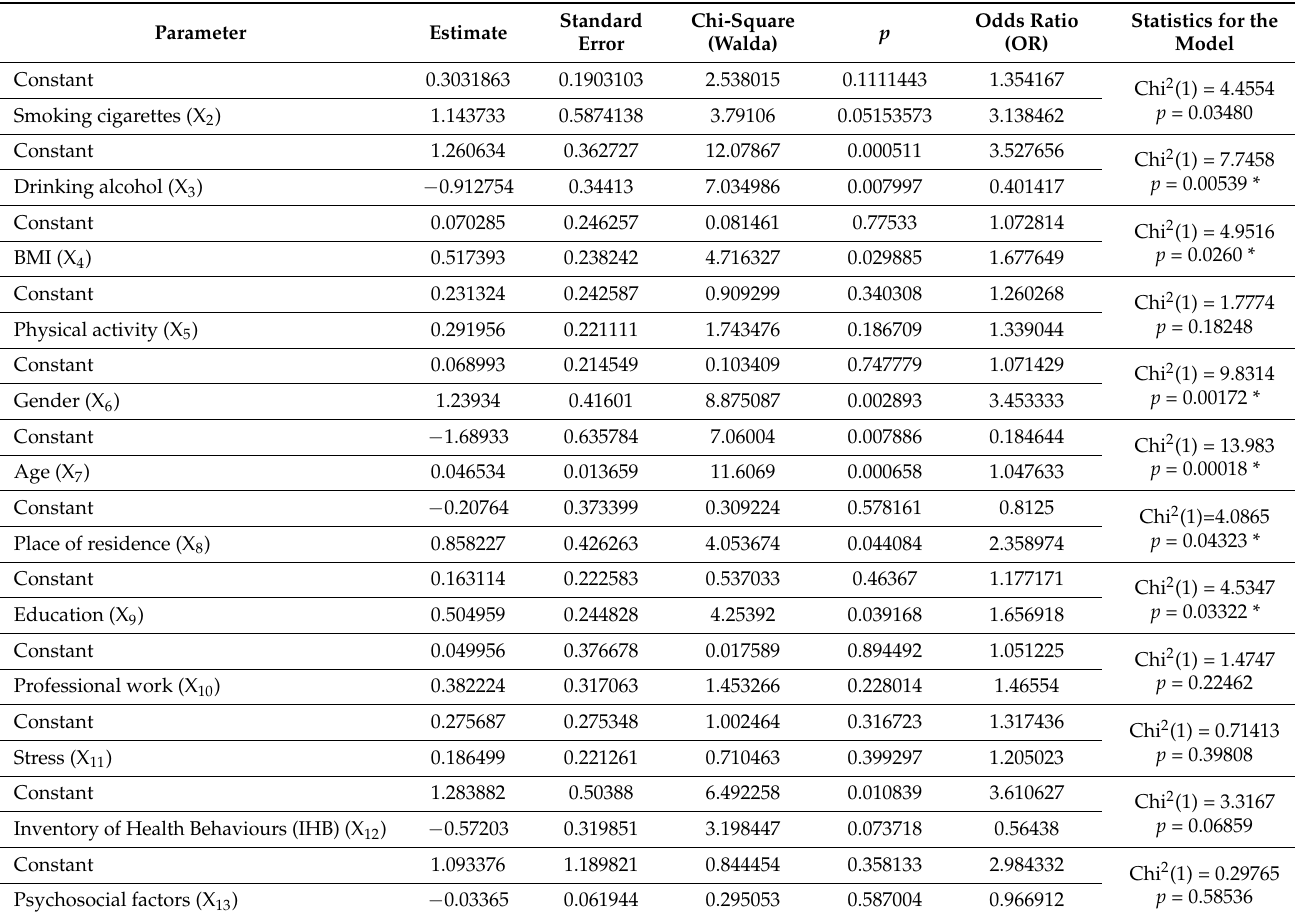
Table 11. Logistic regression score (LRS)—assessment of the relationship between variables considered individually and the probability of an increased level of homocysteine for the CA